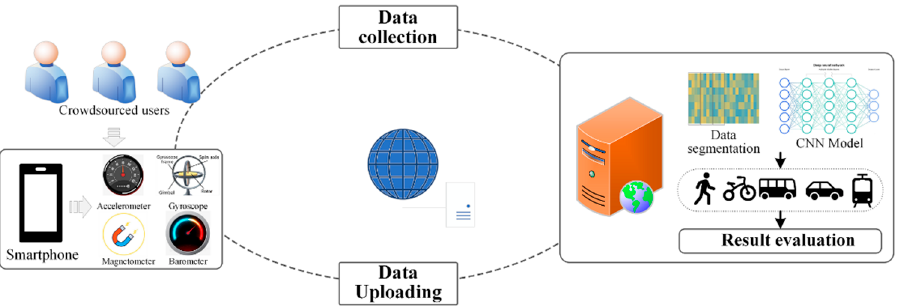
Figure 1. The architecture of the proposed system.